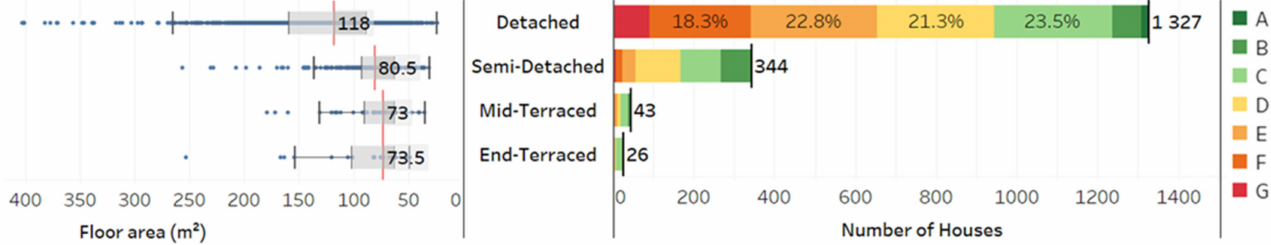
Figure A4. EPC ratings ( right ) and gross floor area ( left ) of house